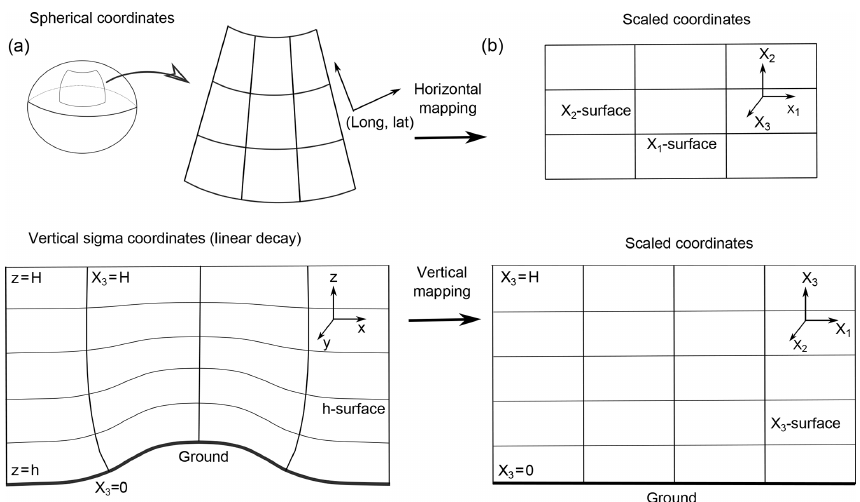
Figure 1. Mapping of coordinates from the physical domain (a) to a brick-like computational domain (b) along the horizontal and vertical dimensions. Horizontal mapping corrects for Earth’s curvature; vertical mapping accounts for topography.